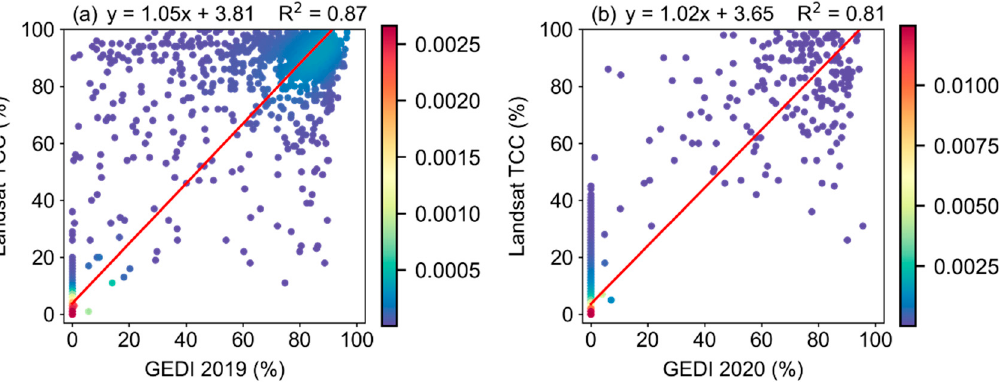
Figure 8. Spatial distribution of TCC change (%/year) from 1990 to 2020 in the Eastern Himalayas: Gains (green to blue) and losses (orange to red) of TCC.